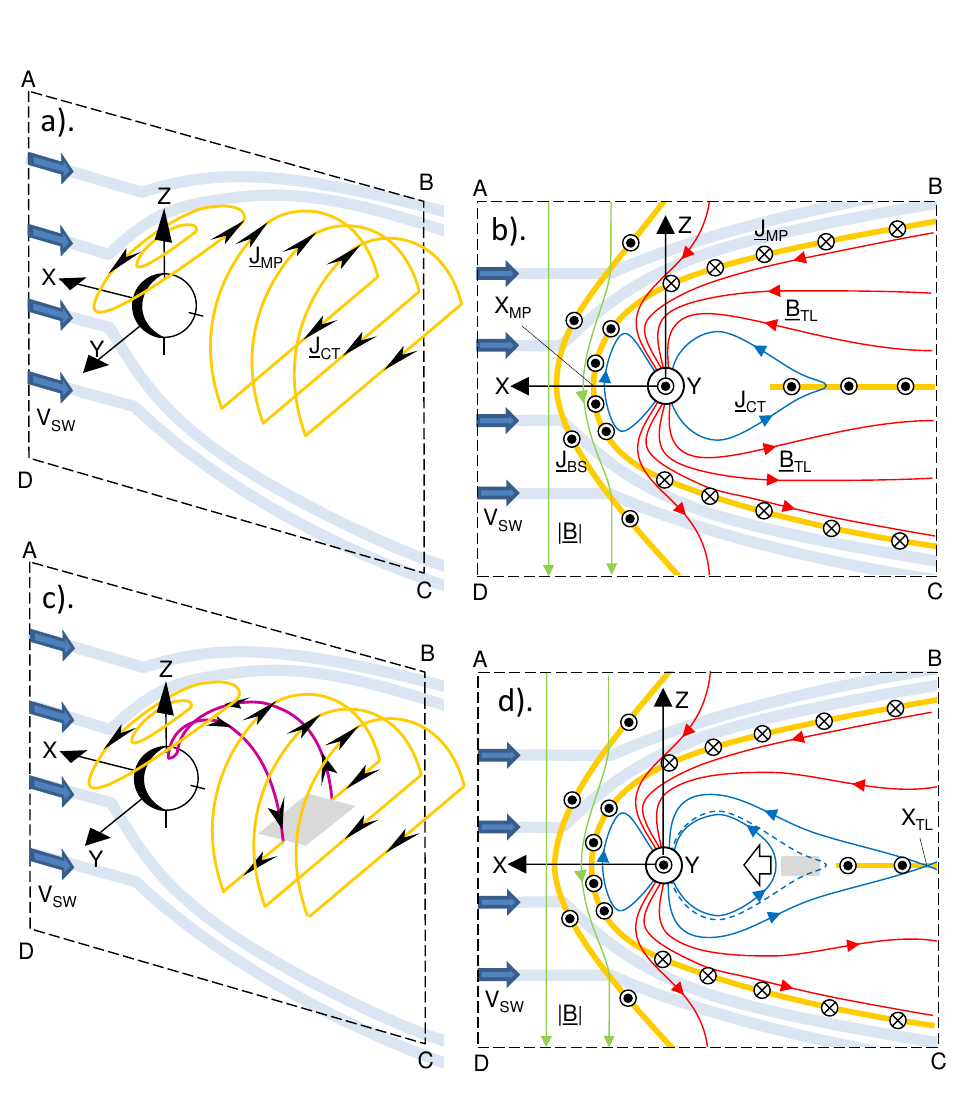
Figure 14: Schematic of Earth’s magnetospheric current systems. Parts (b) and (d) are views of the noon-midnight cross-section of the magnetosphere, ABDC, from the ecliptic on dusk side of the Earth and show current sheets in orange, interplanetary field lines in green, open geomagnetic field lines (that thread the magnetopause) in red and closed field lines (that do not) in blue. Parts (a) and (c) are views of the northern-hemisphere currents in the tail and dayside magnetopause from high northern latitudes in the pre-midnight sector. In all panels 𝑋 , 𝑌 , and 𝑍 are the axes of the GSM reference frame. Parts (a) and (b) are for a substorm growth phase, whereas (c) and (d) are for a substorm expansion phase. 𝐵 is the undisturbed IMF and 𝐽 BS is the current in the Bow Shock. In all panels magnetic reconnection is taking place at 𝑋 MP in the dayside magnetopause. The tail lobe field is 𝐵 TL and the current in the cross-tail current sheet ( 𝐽 CT ) is disrupted in the grey areas in (c) and (d). The mauve currents in (c) are the “substorm current wedge” within which the magnetospheric field lines “dipolarise” at onset (the dashed line in (d) shows the stretched field line before onset and the arrow the associated sunward convection surge of the frozen-in plasma). The “near-Earth neutral line”, 𝑋 TL , is also shown in